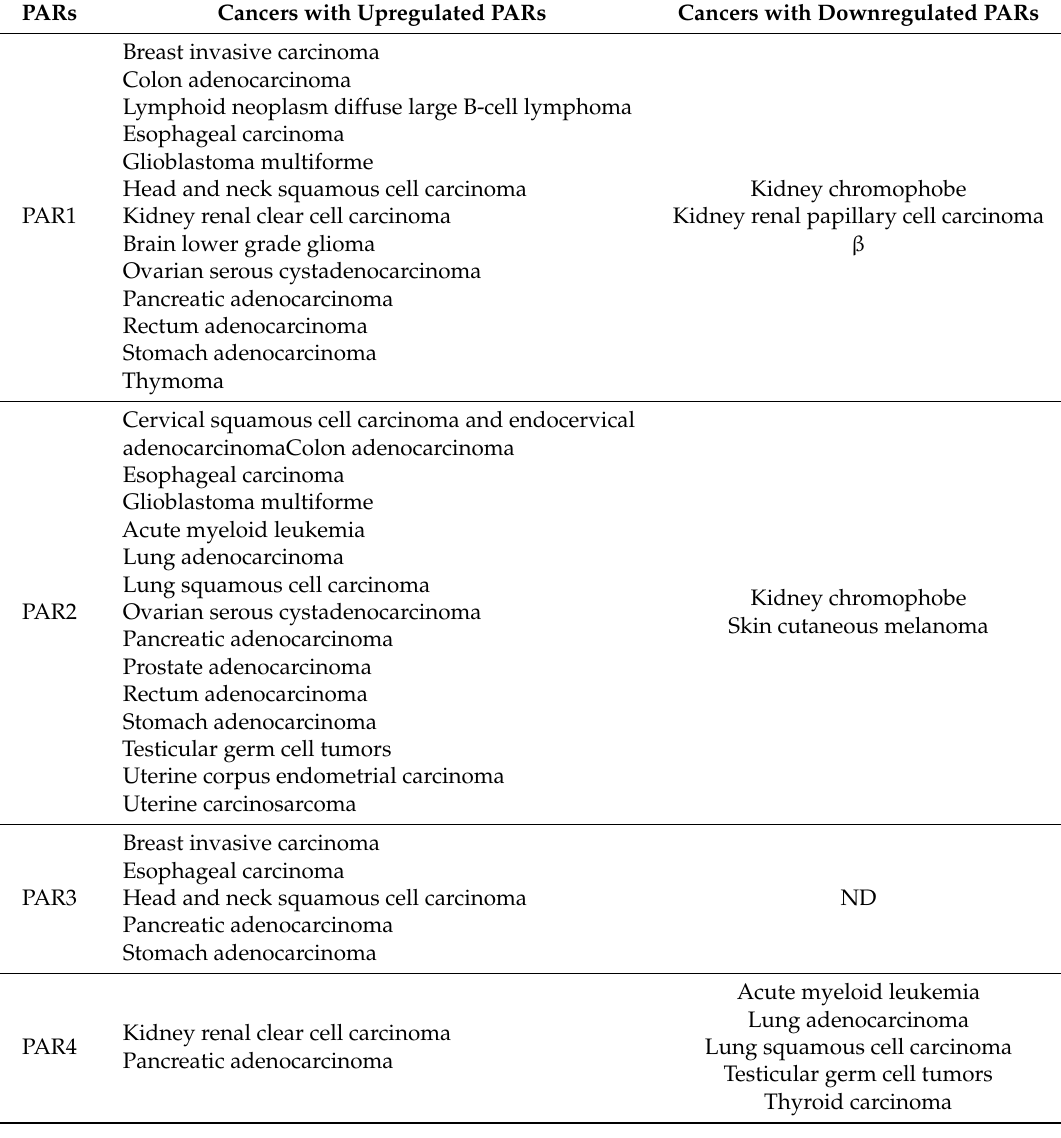
Table 1. Protease-activated receptor (PAR) expression in human cancers. Gene Expression Profiling Interactive Analysis (GEPIA, http://gepia.cancer-pku.cn/), a newly developed online platform using RNA sequencing expression data from the Cancer Genome Atlas (TCGA) and the Genotype-Tissue Expression projects (GTEx) was used to compare tumor versus normal samples in numerous cancer types. The table summarizes the types of cancers that exhibit either upregulation or downregulation of PARs, compared to normal tissue. ND (not